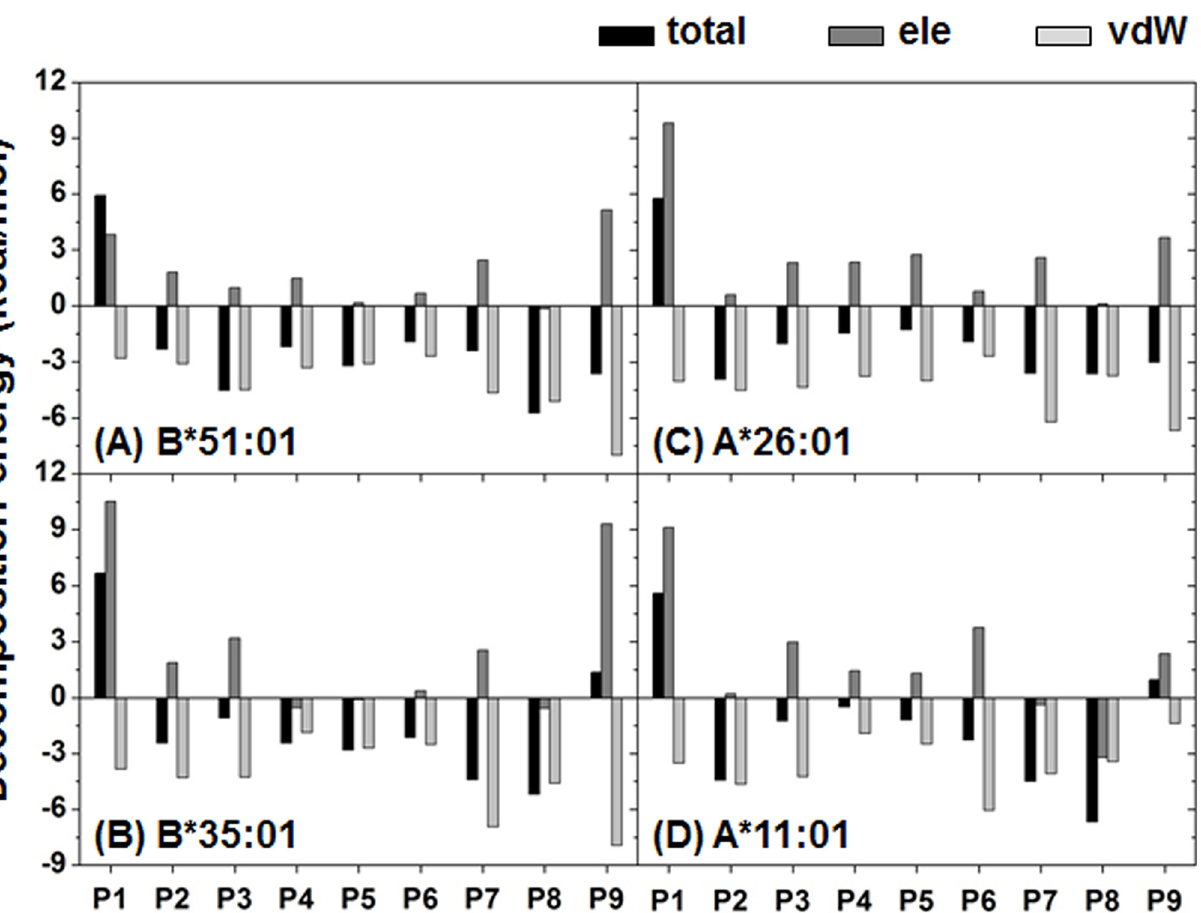
Fig 4. Averaged decomposition energy contributions in HLA binding to MICA-TM. Per-residue decomposition energies and the energy components in terms of the electrostatic (ele) and van der Waals (vdW) interactions for the P1 – P9 residues of MICA-TM.